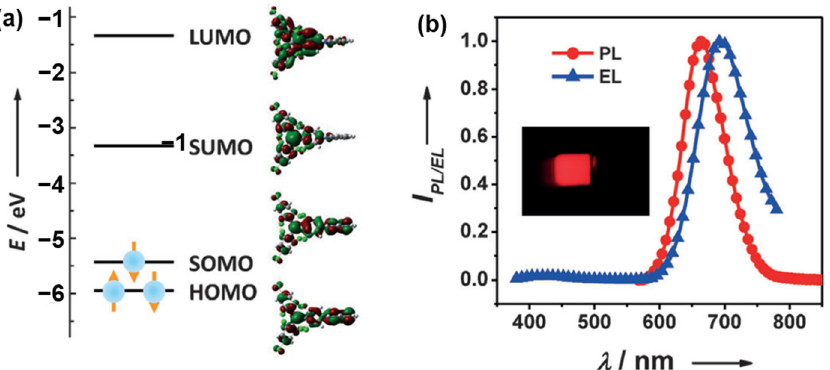
Figure 15. ( a ) The energy levels (left panels) and contour plots (right panels) of the molecular orbitals (LUMO, SUMO, SOMO, and HOMO) of M41 . ( b ) The EL spectrum (7 V) of the OLEDs accompanied by the PL spectra of the doped thin film. The inset shows a photograph of the M41 -based OLEDs operating at 7 V (adapted from ref. [49]).